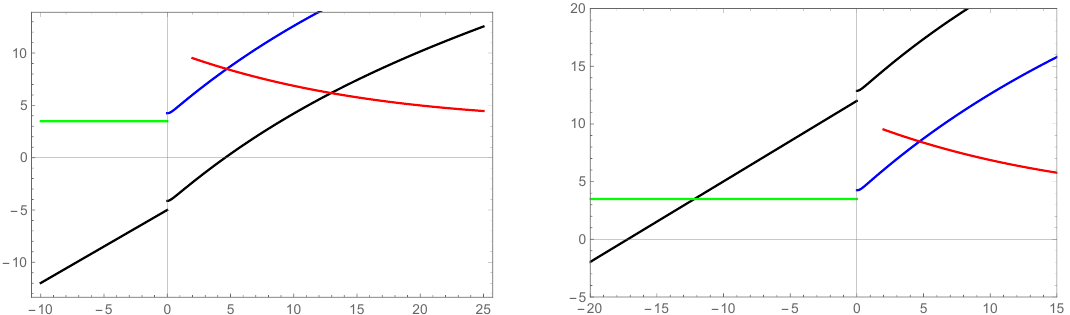
Figure 8 . Two possible scenarios for the entropy saddles as a function of time discussed in the text with a small shockwave entropy. The origin of time is set at shockwave insertion (the vertical scale has also been shifted). Non-island saddles are shown in black and saddles with islands are coloured coded according to (cid:12)gure 6 (green: boundary point in front of shockwave; blue: boundary point behind shockwave, QES in front; red: boundary point and QES behind shockwave). Left : insertion before the original Page time. Right : insertion after the original Page time. Note that the red saddle only comes into being a certain scrambling time after the